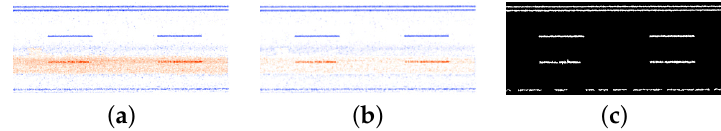
Figure 10. ( a ) The orange part is the interference region. ( b ) The orange part is dimmed compared with ( a ), which means that interference is suppressed. ( c ) The extracted lane